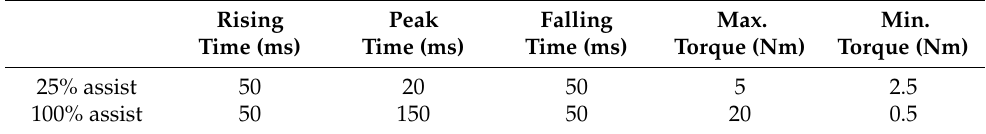
Table 4. The user customized torque profile definitions for the gait experiment.